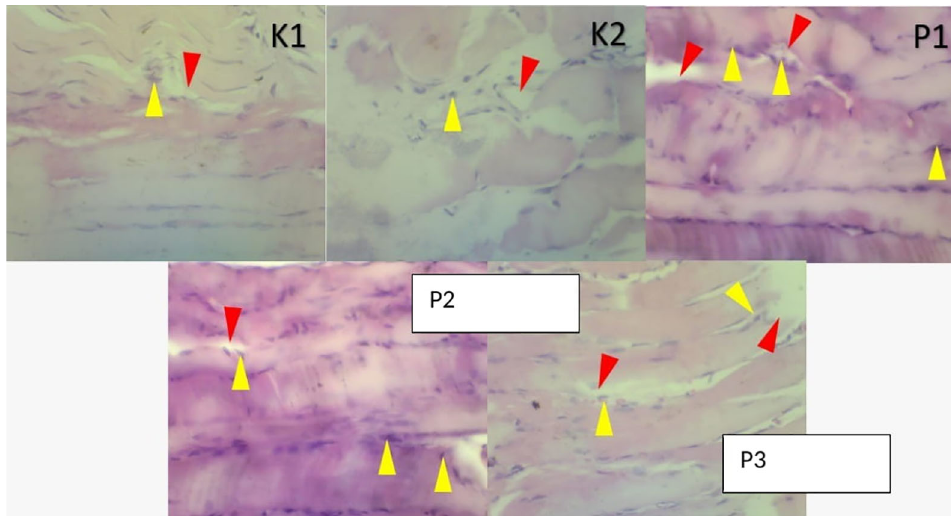
Figure 3. A picture of changes in muscle soleus cells before and after treatment RDF extract (antioxidant exogen). Arrow yellow: inflammatory cells, Arrow red: necrosis.